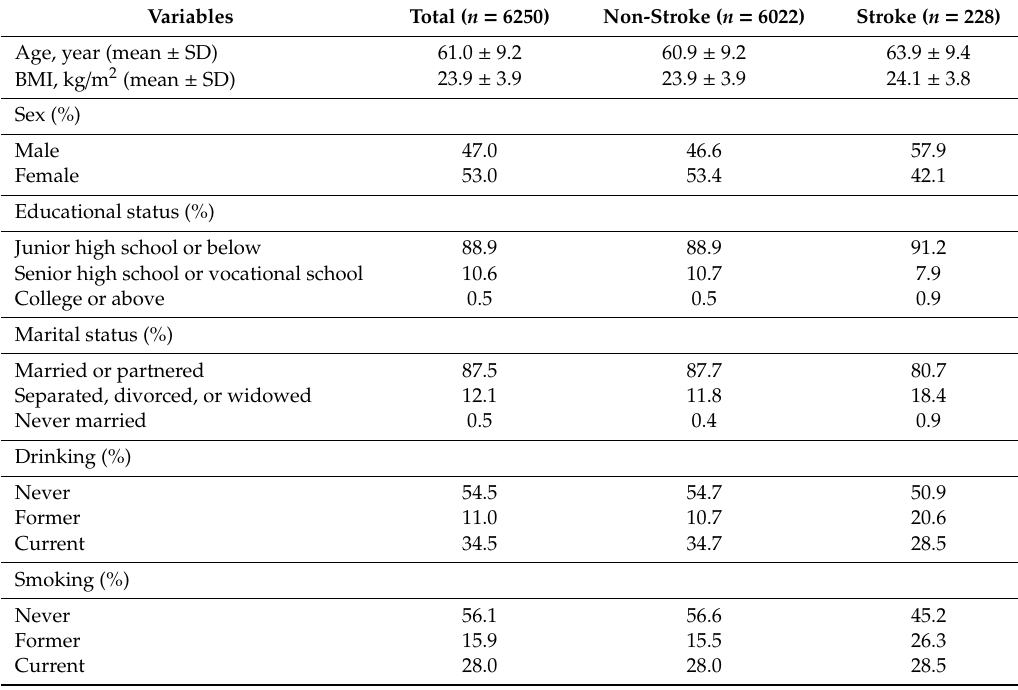
Table 1. Basic characteristics of